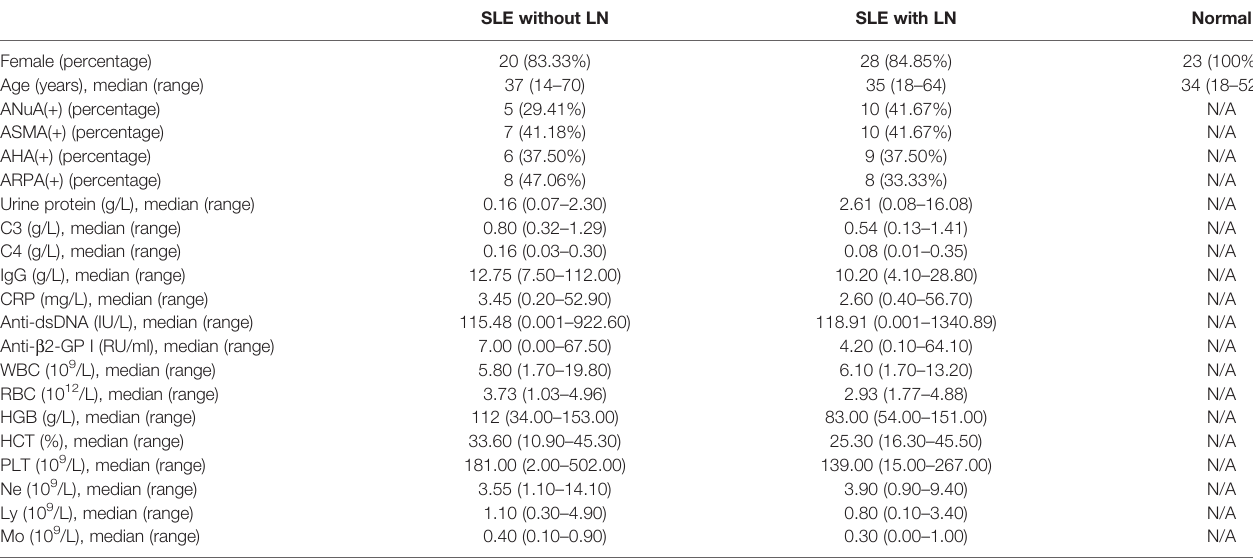
TABLE 1 | Statistics of clinical information of testing group specimens.